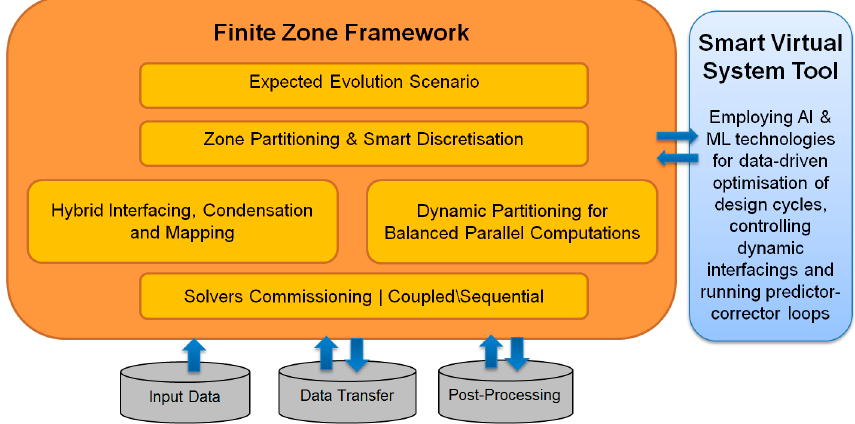
Figure 4. Schematic architecture of finite zone computational system. AI, artificial intelligence; ML, machine learning.